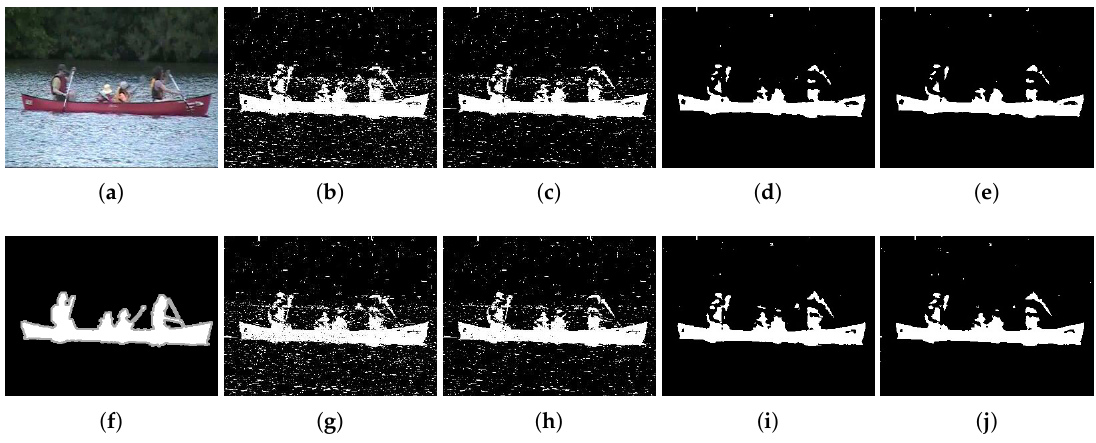
Figure 10. Image results of our method according to the used steps. ( a ) Initial image; ( b ) Binary ( F -measure = 0.564); ( c ) Bin./Temporal ( F -measure = 0.685); ( d ) Bin./Spatial ( F -measure = 0.915); ( e ) Bin./Spat./Tempo. ( F -measure = 0.911); ( f ) Ground truth; ( g ) Fuzzy ( F -measure = 0.574); ( h ) Fuzzy/Tempo. ( F -measure = 0.667); ( i ) Fuzzy/Spat. ( F -measure = 0.9); ( j ) Fuzzy/Spat./Tempo. ( F -measure = 0.943)